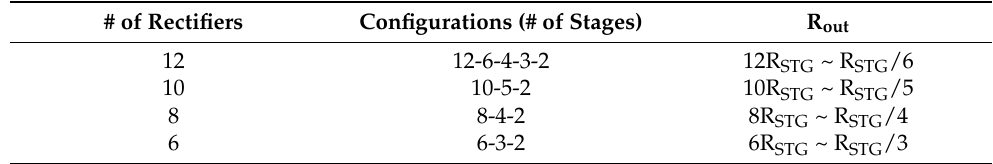
Table 1. Configuration and Rout of each